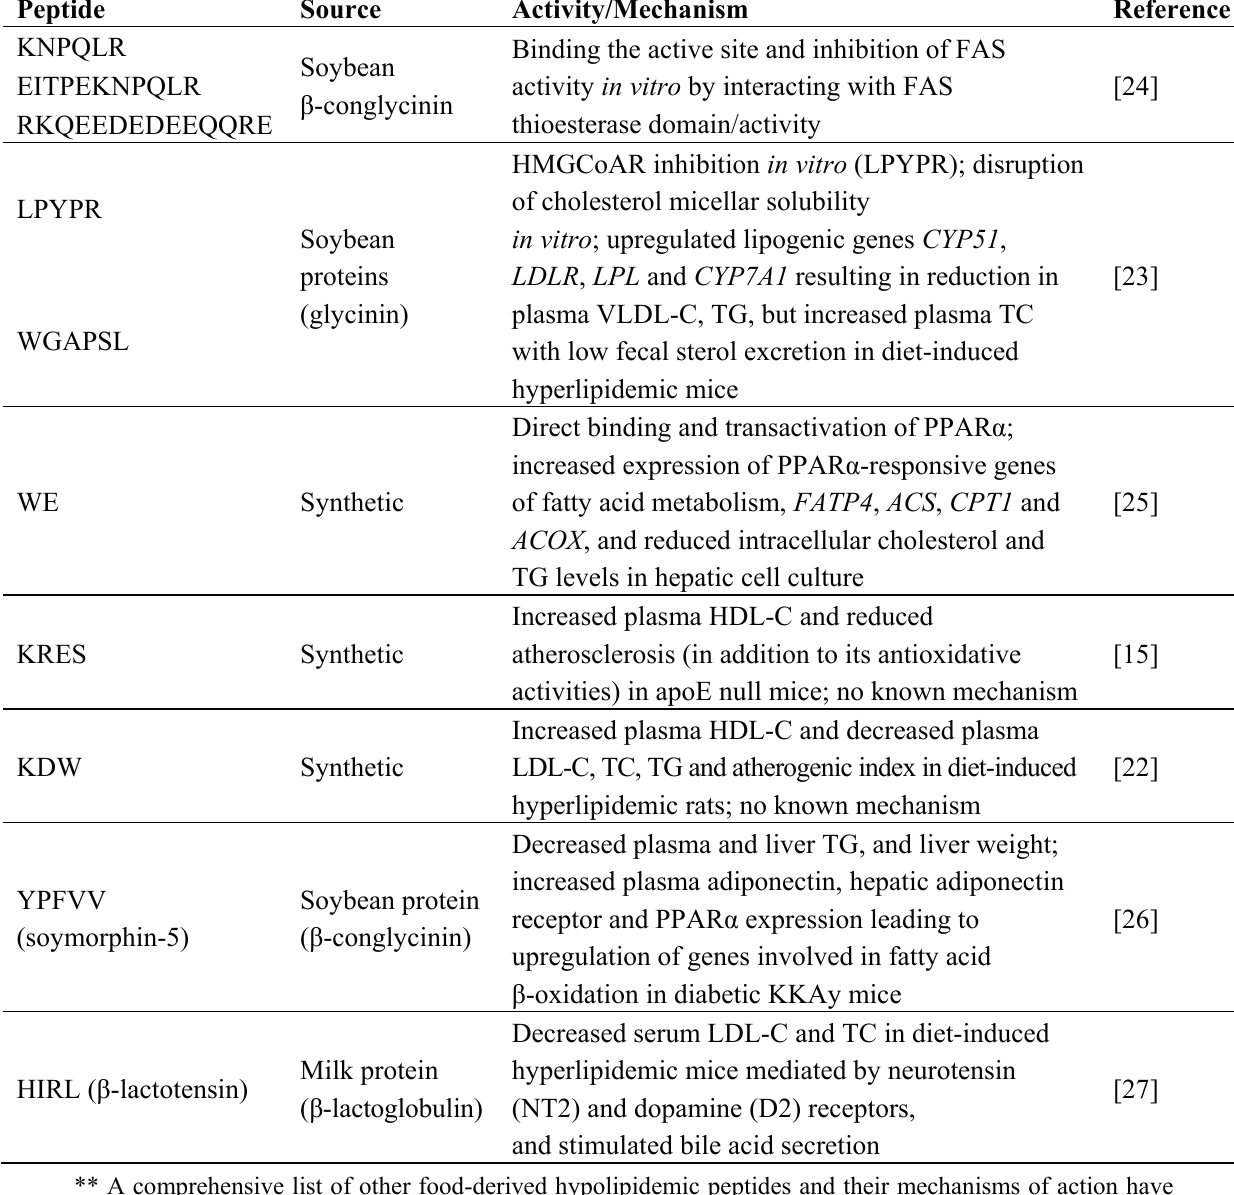
Table 1. Peptide sequences with hypolipidemic activities